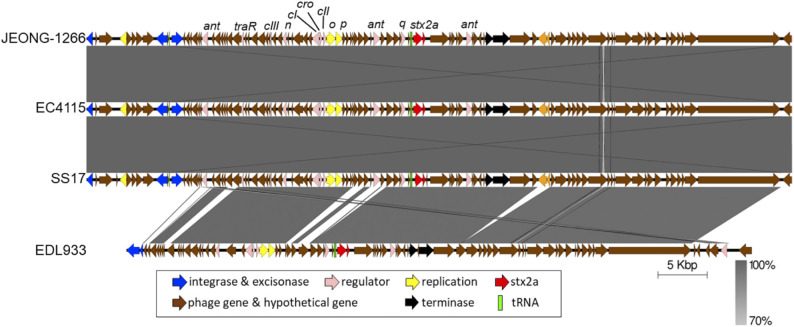
Comparison of Stx2a-encoding prophages. The Stx2a-encoding prophage of JEONG-1266 was compared with the ones in EC4115, SS17, and EDL933. The CDS and tRNA were shown in colored arrows and blocks, respectively. The darkness of gray shade between strains reflects the similarity of the nucleotide sequences of Stx2a-encoding prophages.